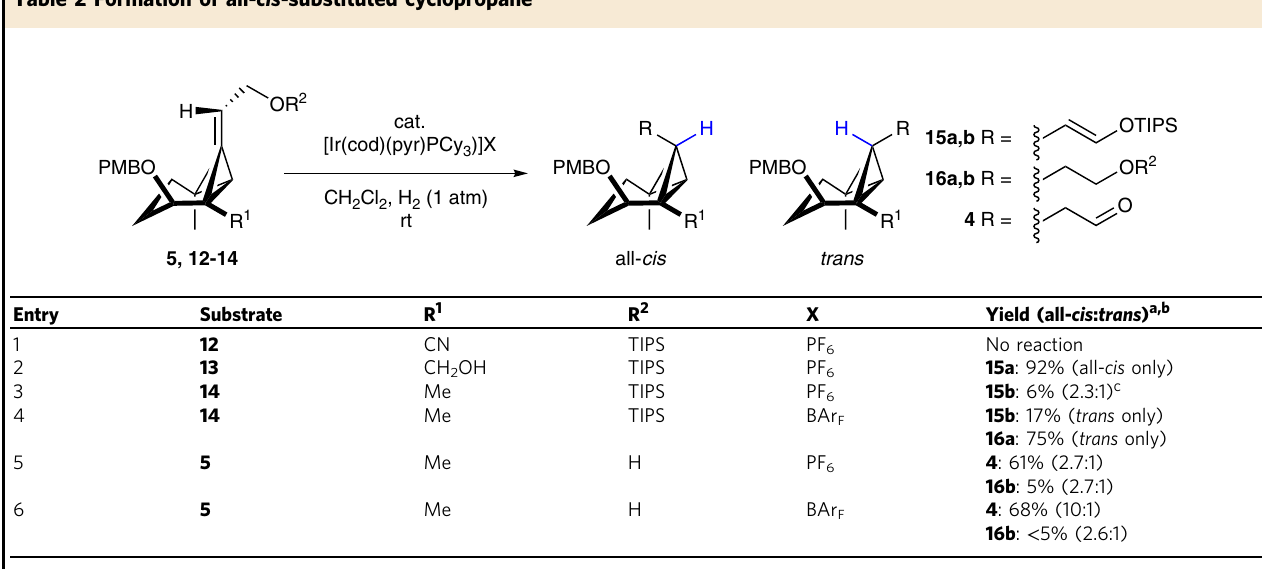
Table 2 Formation of all- cis -substituted cyclopropane